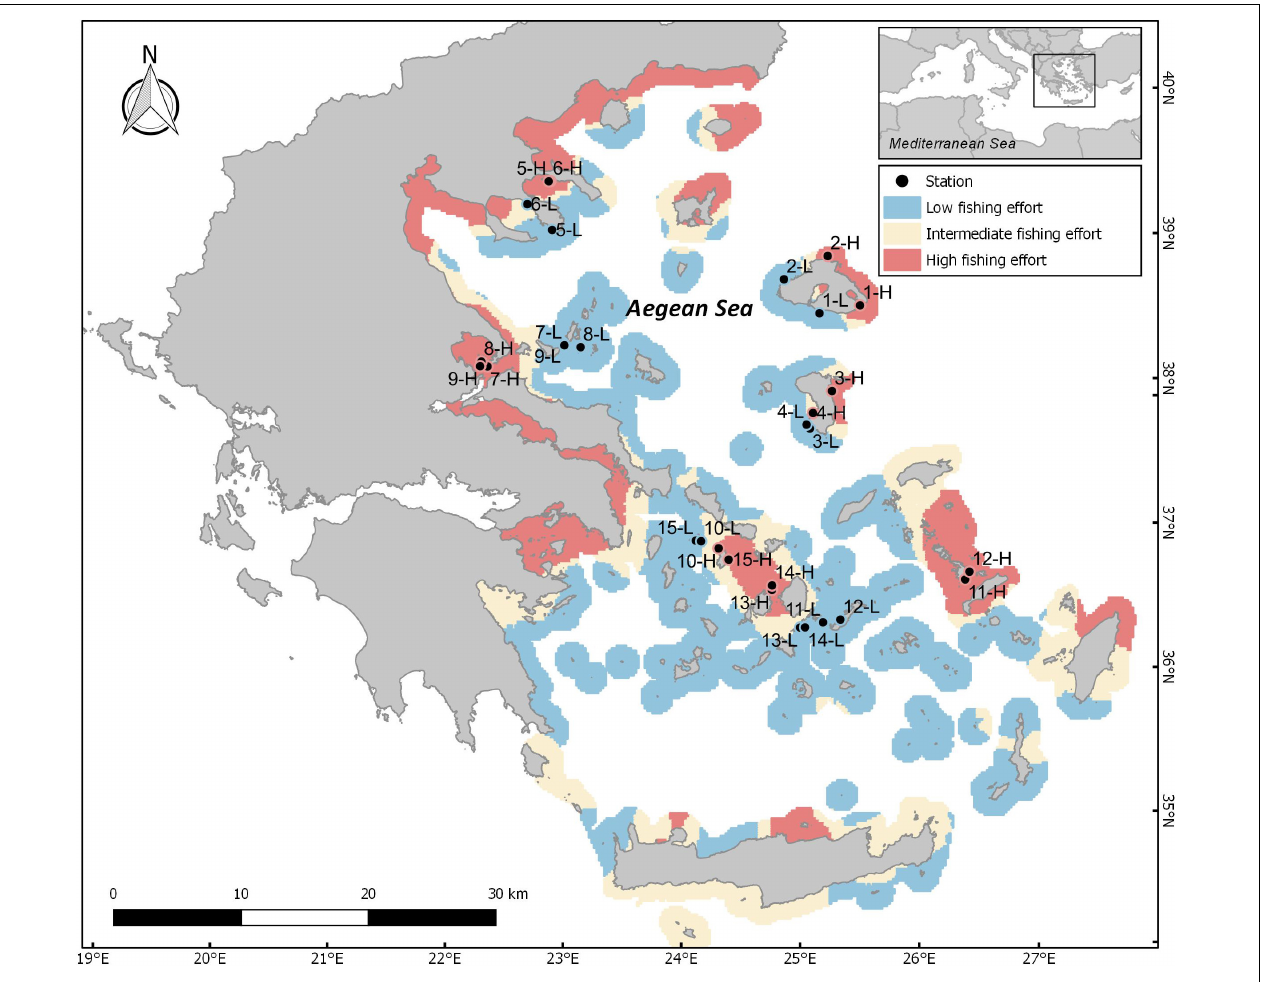
FIGURE 1 | Map of the Aegean Sea depicting areas of different levels of fishing pressure (FP) based on the fishing pressure index developed for small scale fisheries. Blue: areas of low FP, red: areas of high FP, and yellow: areas of intermediate FP. Bullets and numbers indicate pairs of sampling sites; L: low FP sites, H: high FP sites. Station ID numbers 1–9 correspond to N Aegean sites, whereas 10–15 correspond to S Aegean sites.